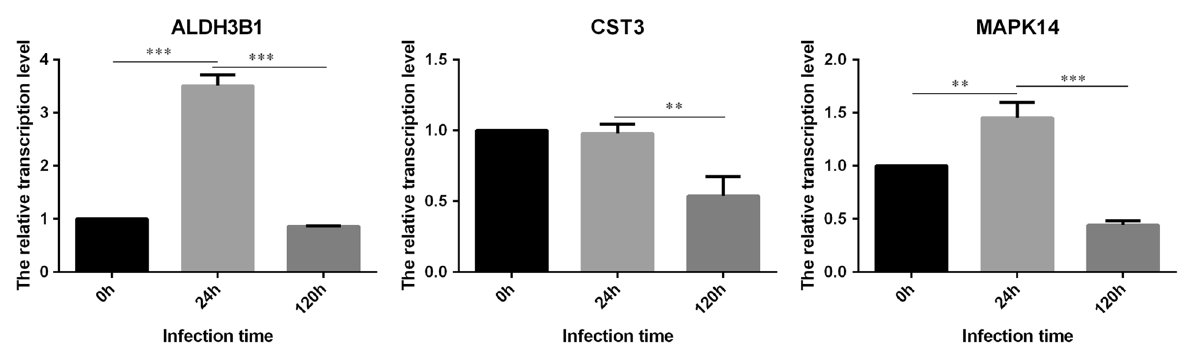
Fig. 6 PBMC analysis of genes of interest by qPCR. Levels of Aldh3b1, Cst3 and Mapk14 mRNAs were detected in PBMCs by qPCR. Aldh3b1 mRNA level was significantly increased only at 24 h; while Cst3 mRNA significant decrease at 120 h post infection compared to the control, which were consistent with the results of PBMC transcriptome analysis. Mapk4 mRNA level was significantly increased at 24 h and decreased at 120 h, being consistent with the results of the omics data. “*” represents p < 0.05, “**” p < 0.01, “***” p <